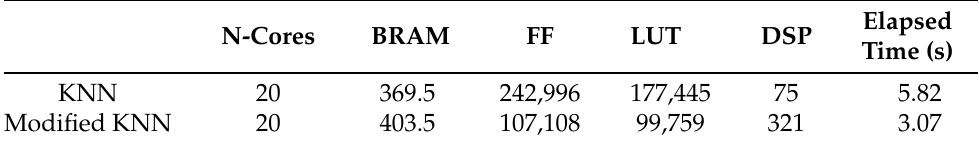
Table 3. Comparison between the KNN algorithm and the modified KNN algorithm for 100 K input symbols using 20 cores on the